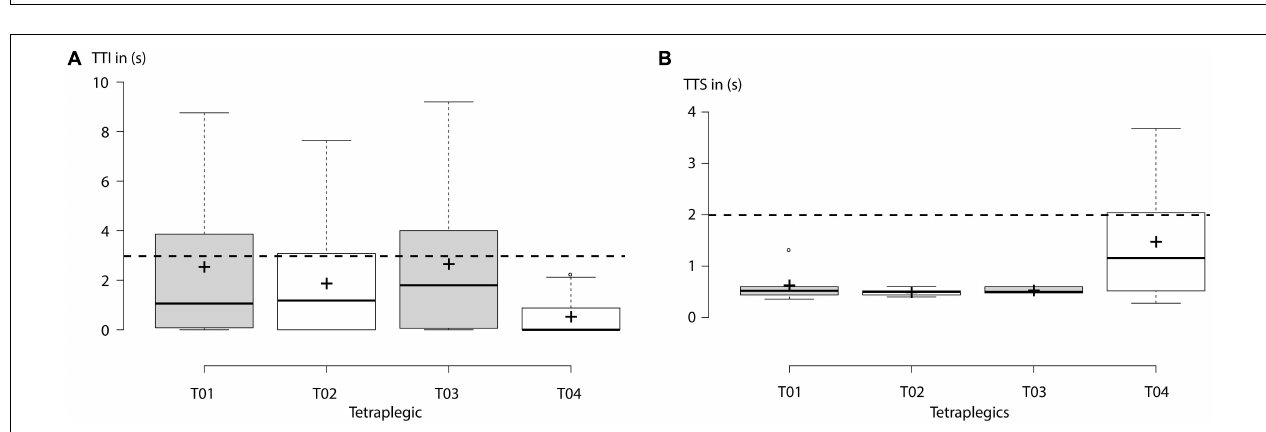
FIGURE 5 | Healthy participants: (A) “Time to initialize” (TTI) electroencephalography (EEG)-controlled closing motions of the left- or right-hand exoskeleton for each participant. Horizontal dashed line indicates the threshold for fluency criterion set at 3 s. Average TTI across all subjects ranged below 3 s, documenting fluent control. (B) “Time to stop” (TTS) an ongoing closing motion by using short horizontal oculoversions (HOVs). Horizontal dashed line indicates the threshold for safety criterion set at 2 s. Centerlines of boxplot show the median, while crosses show the mean. Box limits indicate the 25th and 75th percentiles.